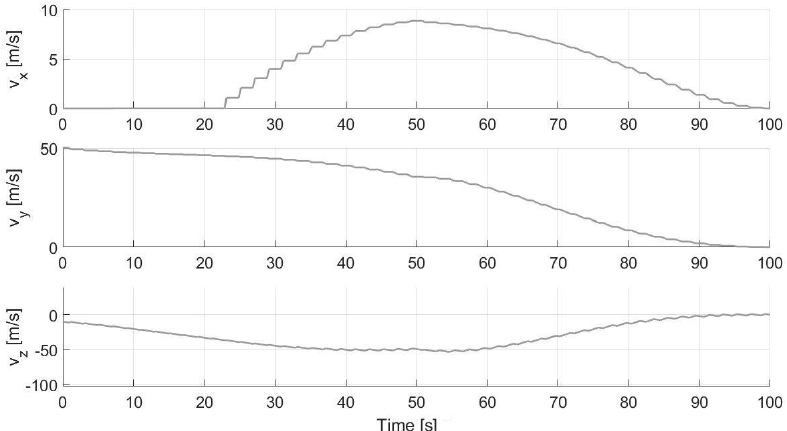
Figure 24. Time-history of velocity for the hardware simulation.